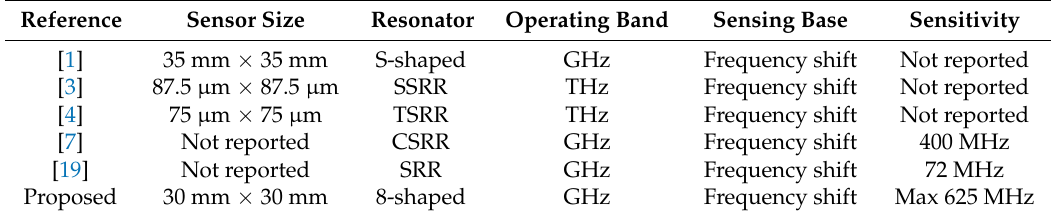
Comparative characteristics of the proposed sensor with previous related